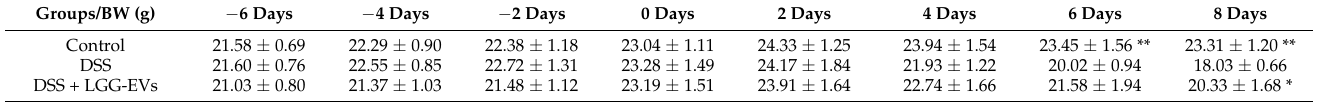
Table 1. The change of body weight among different treatment groups ( n = 7).